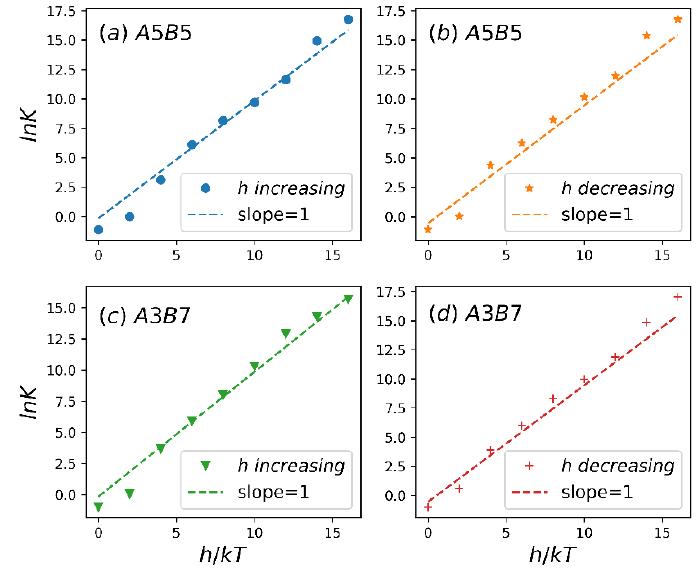
Figure 8. The logarithm of equilibrium constant, ln K , versus the reversible bond strength, h . A5B5 system in h increasing process ( a ) and h decreasing process ( b ). A3B7 system in h increasing process ( c ) and h decreasing process ( d ).